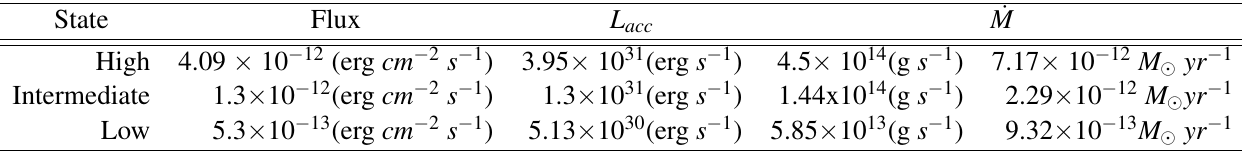
Table 7 Ultraviolet luminosities and accretion rate for the spectral line C IV (1550Å ).